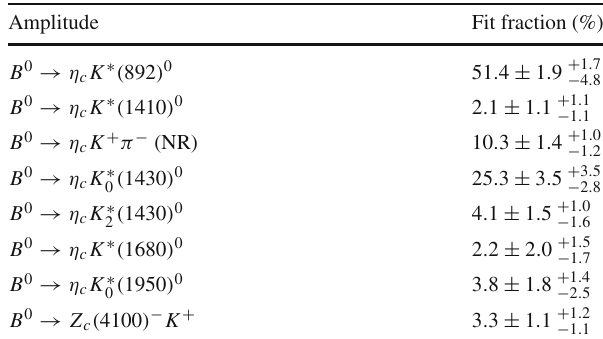
Table 7 Fit fractions and their uncertainties. The quoted uncertainties are statistical and systematic, respectively Amplitude